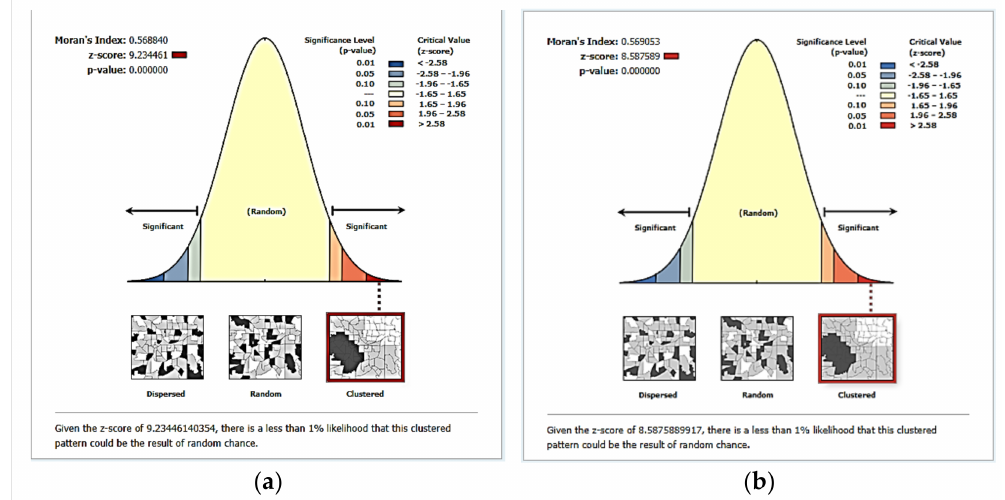
Figure 2. Results of ArcGIS Moran’s I spatial autocorrelation: ( a ) Confirmed COVID-19 cases; ( b ) socio-economic vulnerability (Source: Results of secondary data processing,